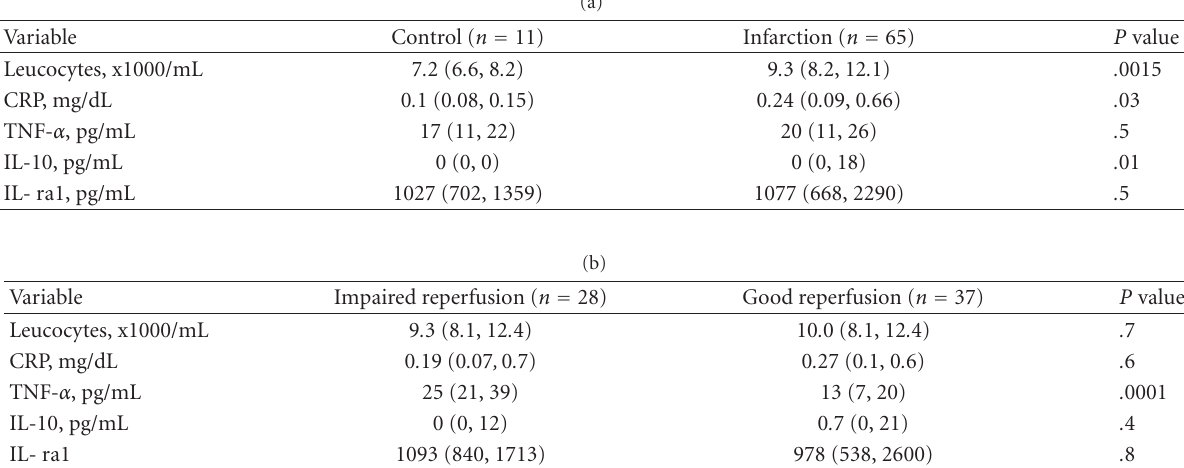
Table 2. Inflammatory status. Data are presented as median value with 25th and 75th percentiles. (a) comparison of control group with AMI patients. (b) inflammatory parameters of AMI patients with impaired reperfusion as compared to AMI patients with good